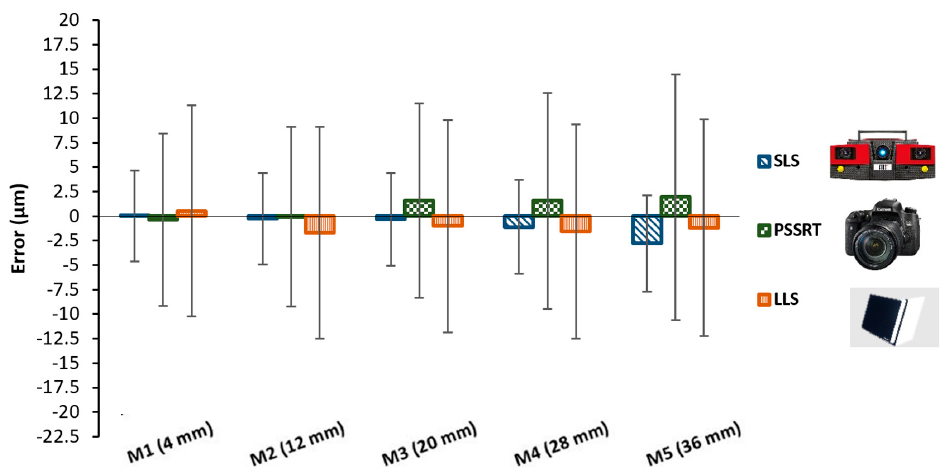
Figure 11. Results obtained considering unidirectional lengths.